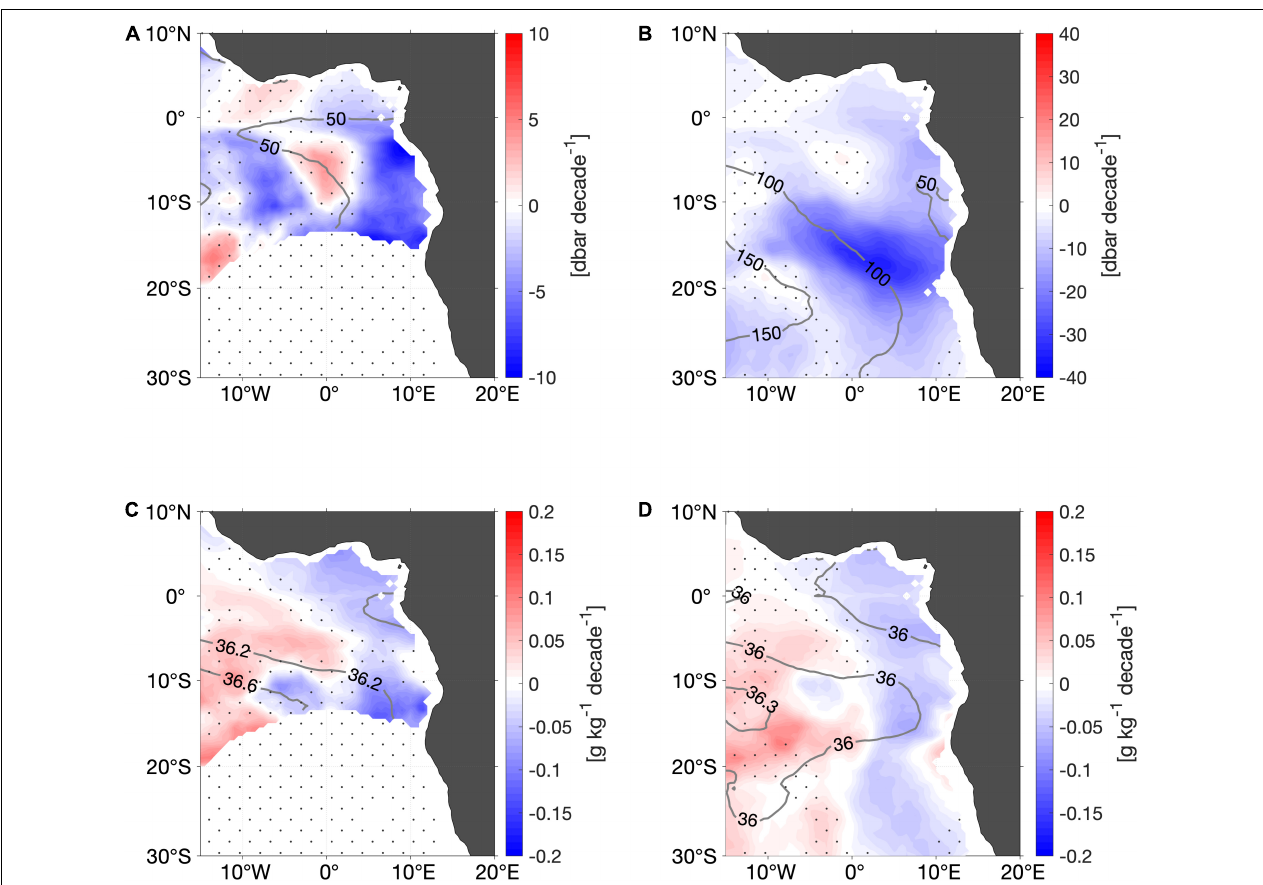
FIGURE 6 | Decadal trend of pressure of the isopycnal surfaces (A) 25.5 kg m − 3 and (B) 26.0 kg m − 3 and decadal trend of absolute salinity on the isopycnal surfaces (C) 25.5 kg m − 3 and (D) 26.0 kg m − 3 from Argo for the time period of 2006–2019. Trends are computed from the anomalies relative to the seasonal mean. Gray contour lines show the mean fields on each isopycnal surface for the time period of 2006–2019. Areas where the trend is not of 95% significance are stippled. Please note, positive trend of pressure of isopycnals surfaces refers to a deepening of the isopycnals. Shelf regions below 2,000 dbar are blanked